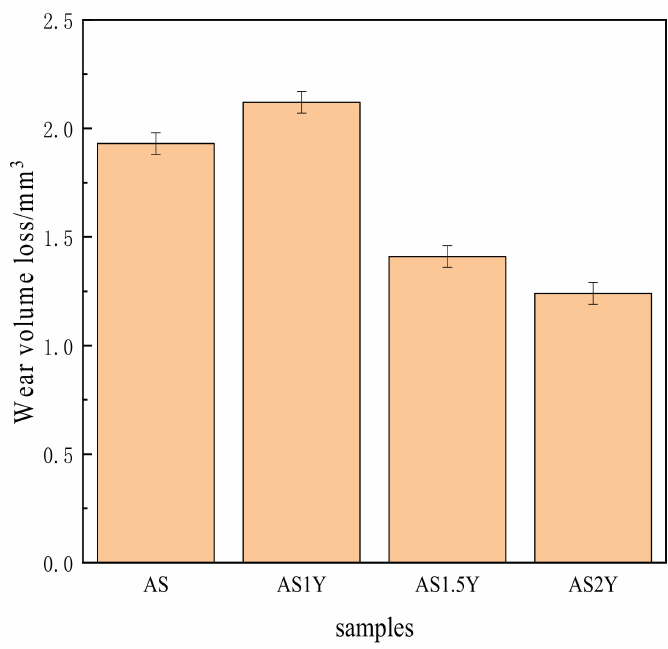
Figure 7. Influence of Y 2 O 3 addition on the wear volume losses of the